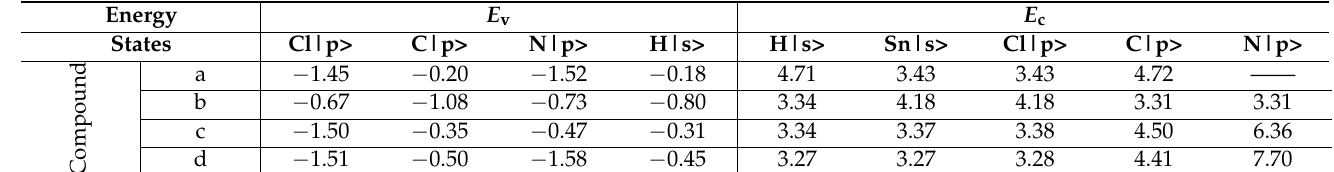
Table 4. The possible first transition and the energy corresponding deduced from the dielectric function and the partial density of states. Figure 5. Variation in the real and imaginary parts of the dielectric function as function of energy of the different studied compounds: ( a ) (NH 3 (CH 2 ) 2 C 6 H 5 ) 2 [SnCl 6 ], ( b ) (C 6 H 10 N 2 )[SnCl 6 ], ( c ) (C 9 H 14 N) 2 [SnCl 6 ], and ( d ) (C 8 H 12 N) 2 [SnCl 6 ].